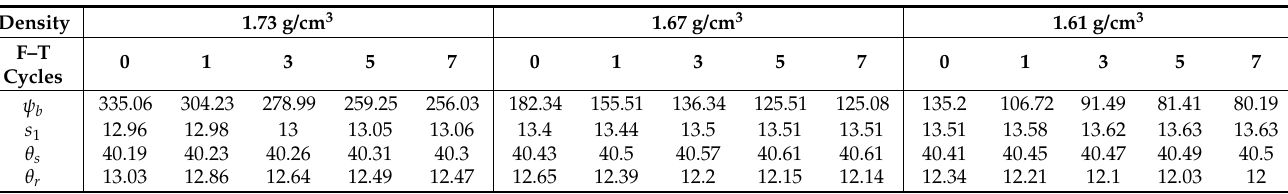
Table 2. SWCC characteristic parameters